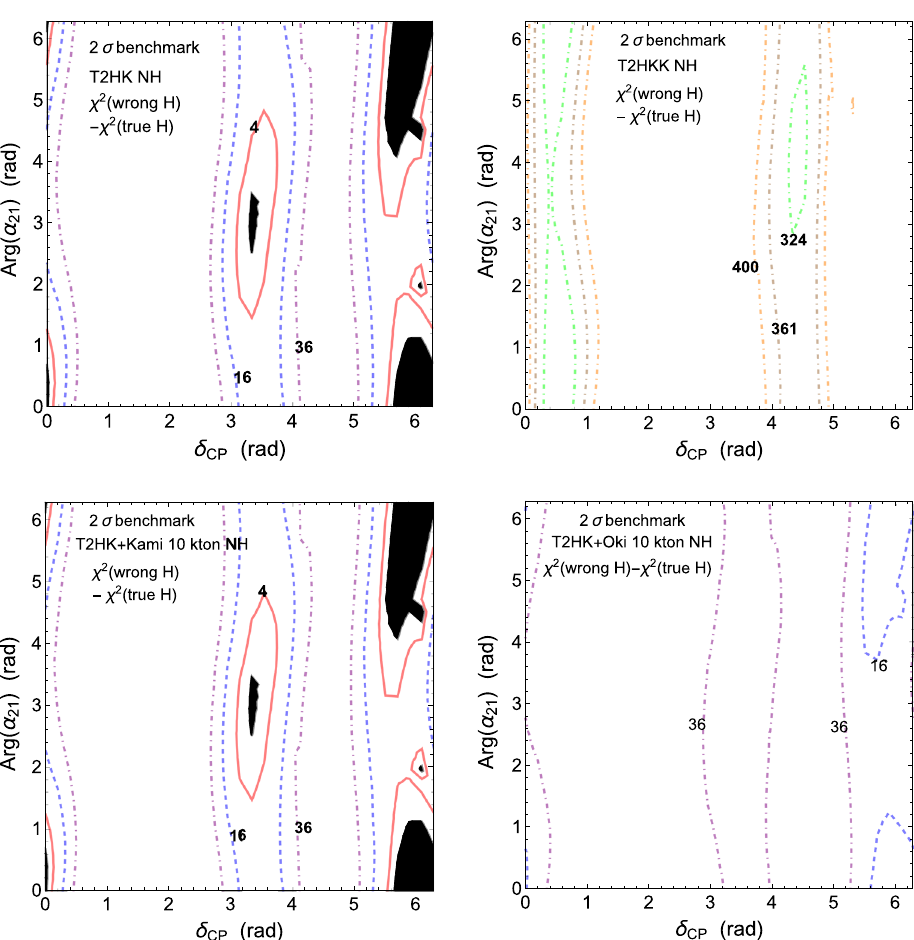
Fig. 12 The difference between the minima (with respect to δ CP only) of χ 2 ((cid:20)) for the wrong and true mass hierarchy, { min χ 2 ( wrong H ) − min χ 2 ( true H ) } . The benchmark with Eq. (37) is assumed, and the true mass hierarchy is normal. The upper-left, upper-right and lower- right subplots correspond to the T2HK, the T2HKK, and the plan of the T2HK plus a 10 kton water Cerenkov detector at Oki, respec- tively. For comparative study, we show in the lower-left a subplot